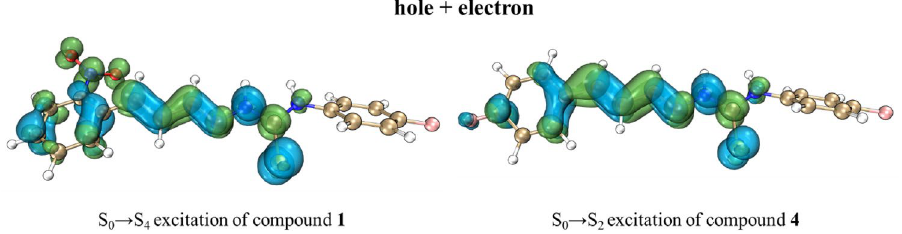
Figure 13. Hole + electron surfaces plot of excitationsS 0 → S 4 of compound 1 (left) and S 0 → S 2 of compound 4 (right). Hole are the blue surface and electron are the green surface.